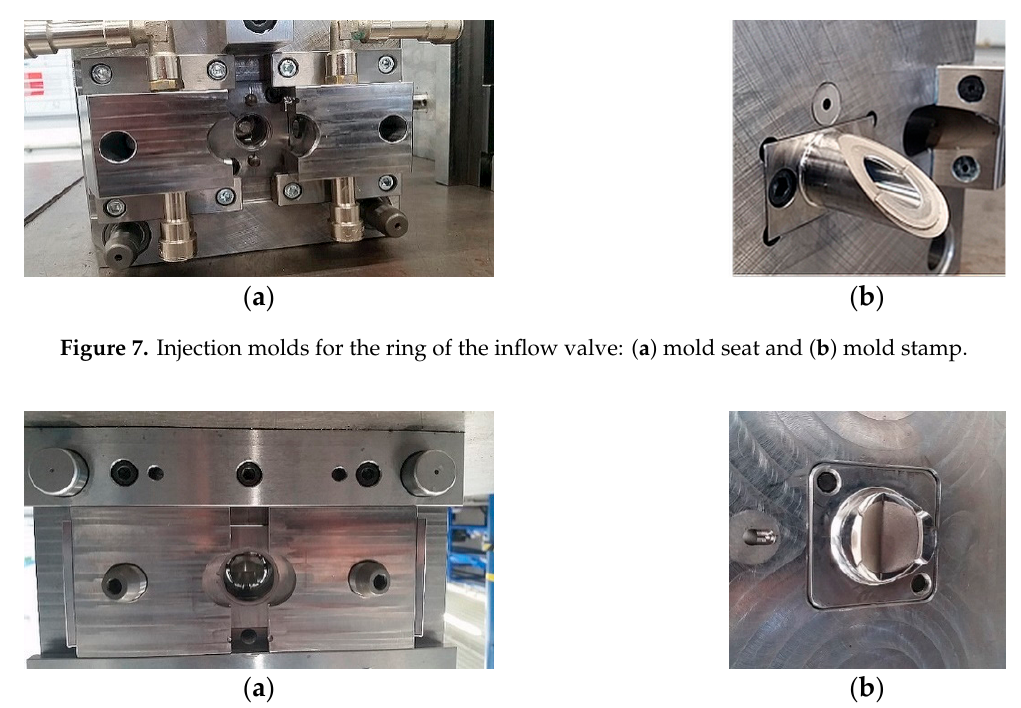
Figure 8. Injection mold for the ring of the outflow valve: ( a ) mold seat and ( b ) mold stamp.